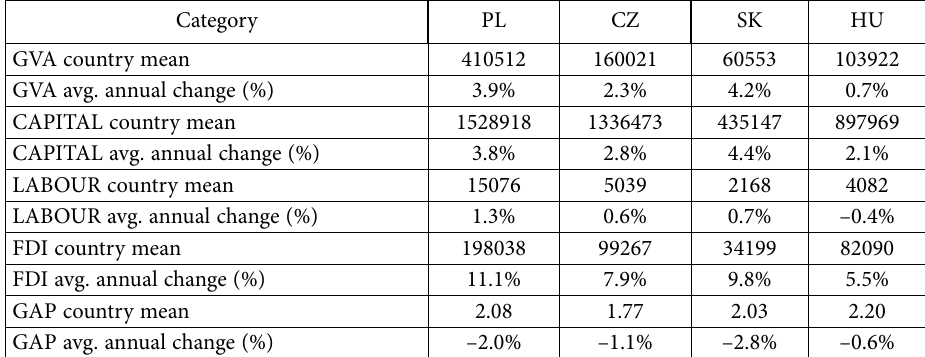
Table 1. Summary statistics for the Visegrad countries in 2004–2013 (source: own study based on Eurostat data) Category PL